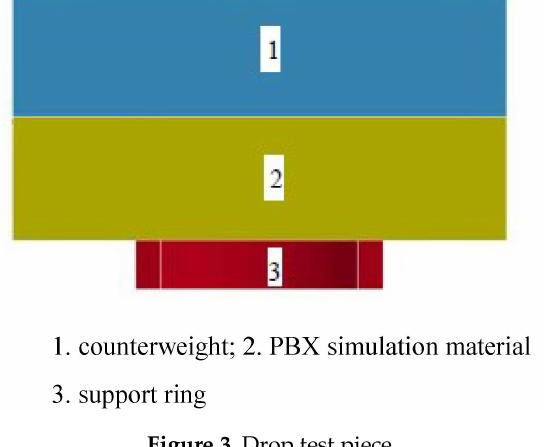
Figure 3. Drop test